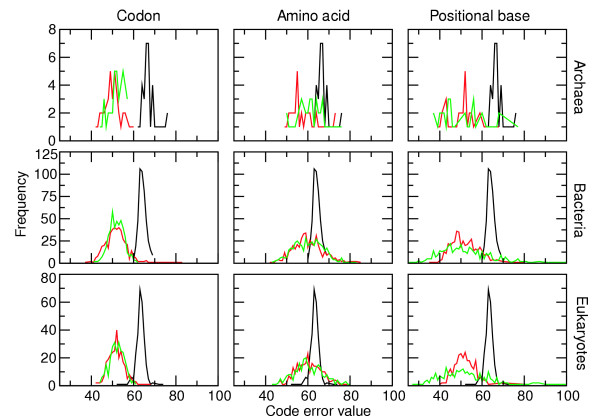
Code-error values for actual and permuted codon usages. The usages are displayed for three randomization algorithms and each domain of life. Rows: archaea, bacteria, and eukaryotes. Columns (randomization algorithms): codon, amino acid, positional base. Black, biological (unpermuted); red, permuted; green, random. Variability is always much less in the biological codon usages (black lines) than in any of the random or randomized usages, and the mean is always higher, suggesting that the biological codon usages are constrained to a narrow band but are not optimized for error minimization.